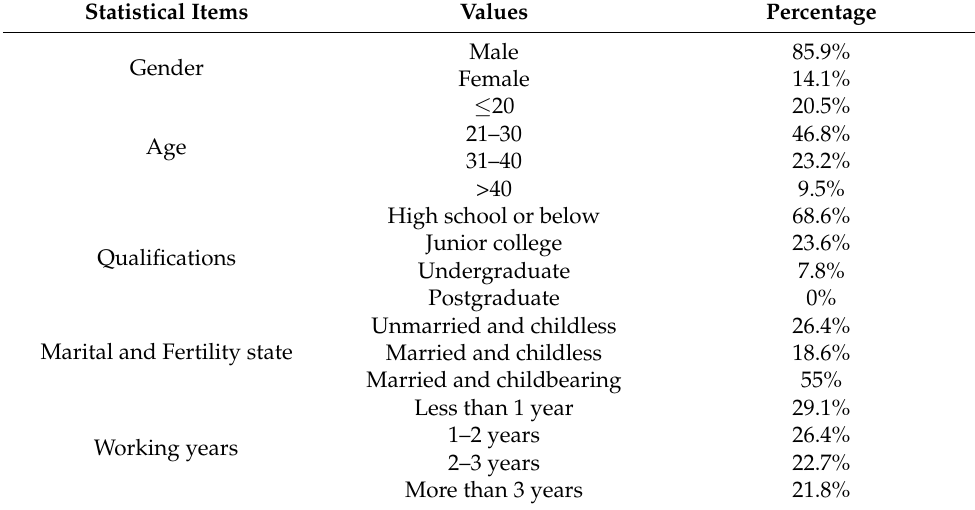
Table 2. Demographic characteristics of interviewees.